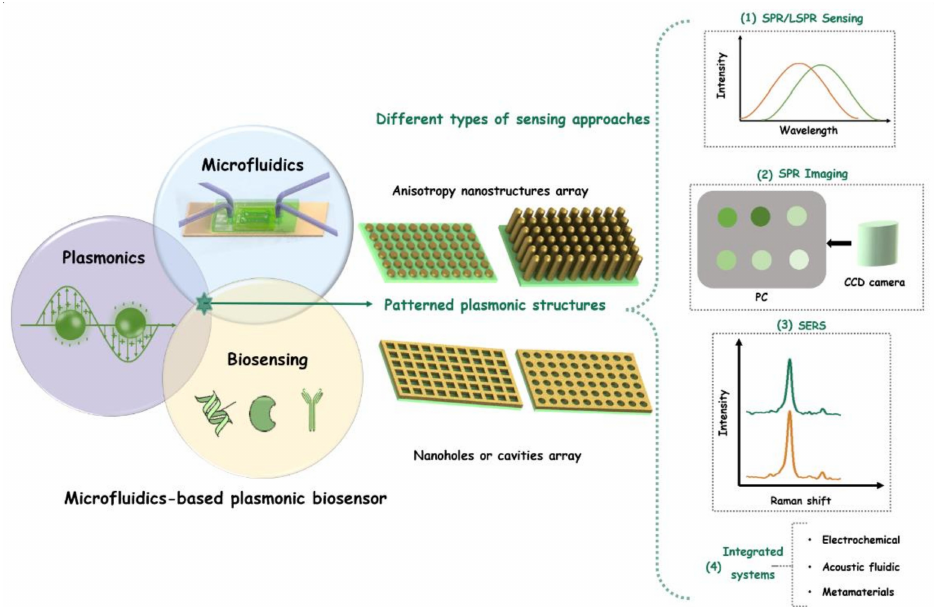
Figure 1. Schematic illustration of microfluidic-integrated plasmonic biosensor system based on patterned plasmonic arrays with different types of sensing